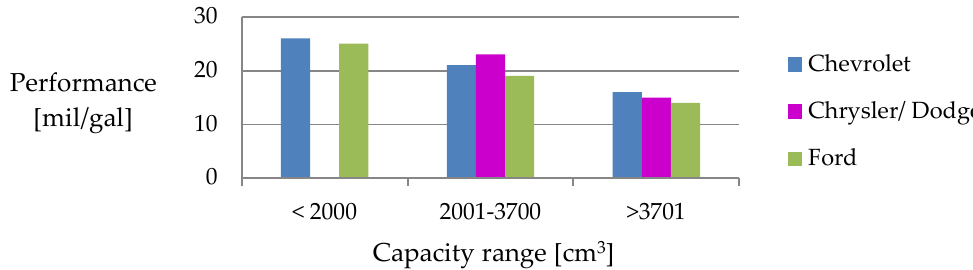
Figure 13. Performance in individual engine capacity ranges among American car brands. Source: